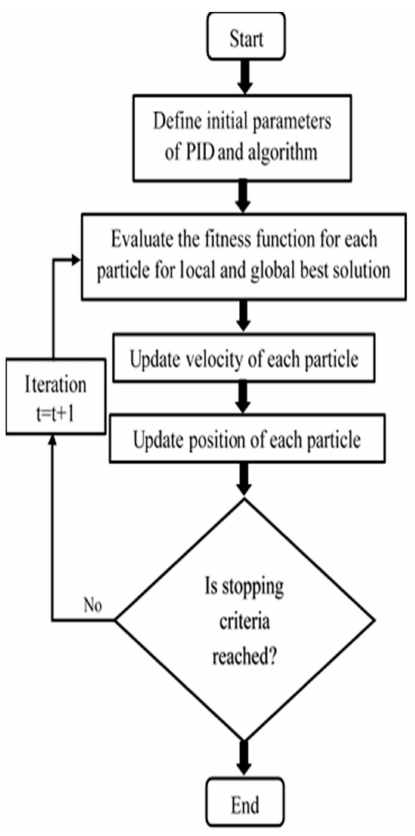
Figure 9. Flow chart of the PSO algorithm.